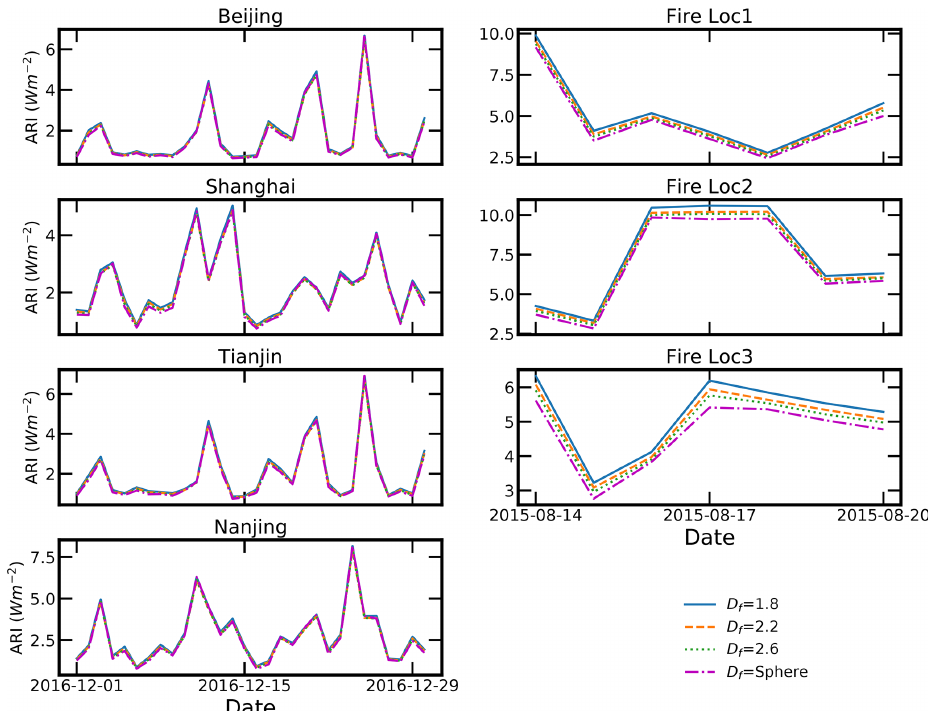
Figure 13. The all-sky BC ARI in the typical urban polluted cities in eastern China and fire sites in the northwest US calculated using different BC